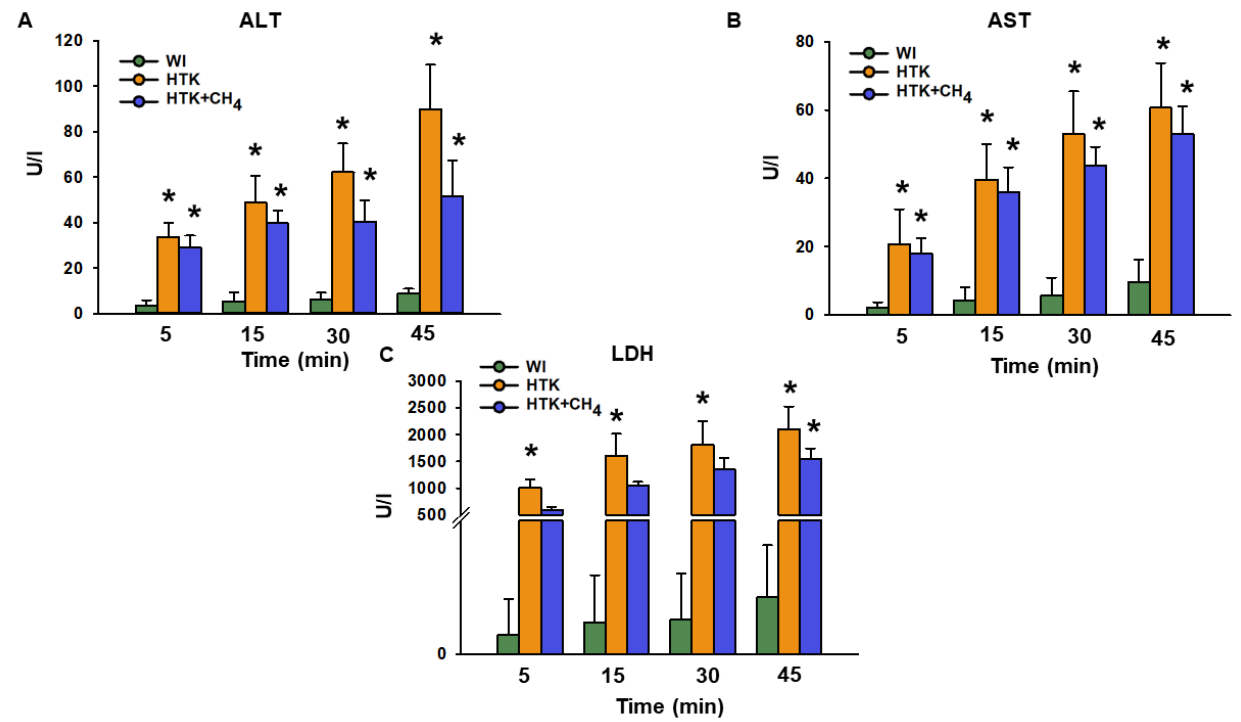
Figure 4. Liver necroenzymes. ( A ) Alanine aminotransferase (ALT), ( B ) aspartate aminotransferase (AST) and ( C ) lactate dehydrogenase (LDH) measured from effluent Krebs solution. Data at 45 min represent the cumulative necroenzyme content. The WI group is marked green, the HTK group is marked yellow and the HTK + CH 4 group is marked blue. Data are presented as means ± SD. * p < 0.05 vs. WI; (one-way ANOVA and Tukey’s test).